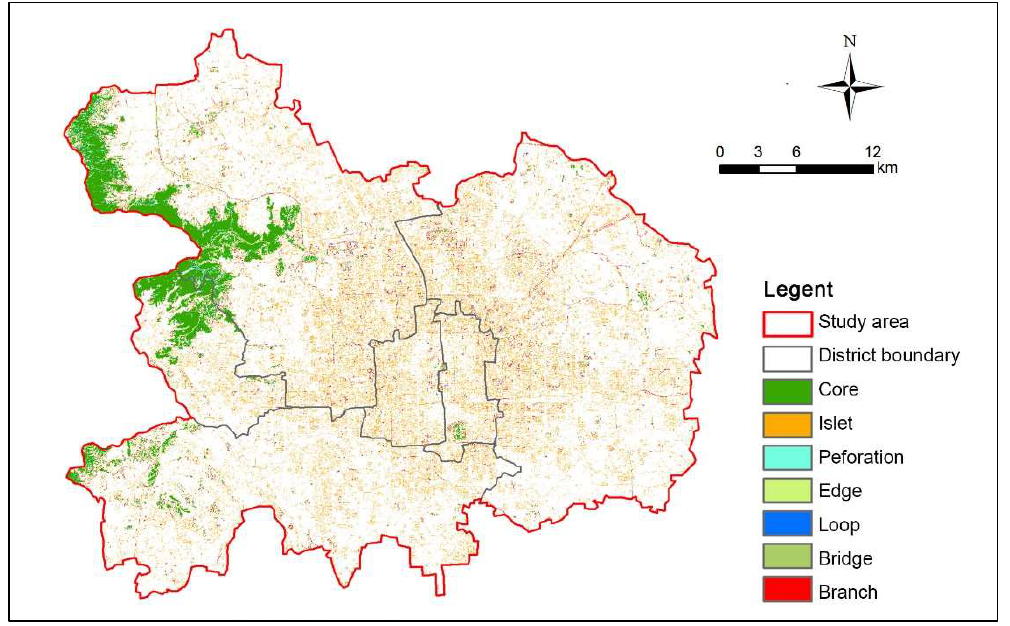
Figure 3. The analysis results of MSPA landscape types. Table 4. The area and proportion of landscape types based on MSPA.